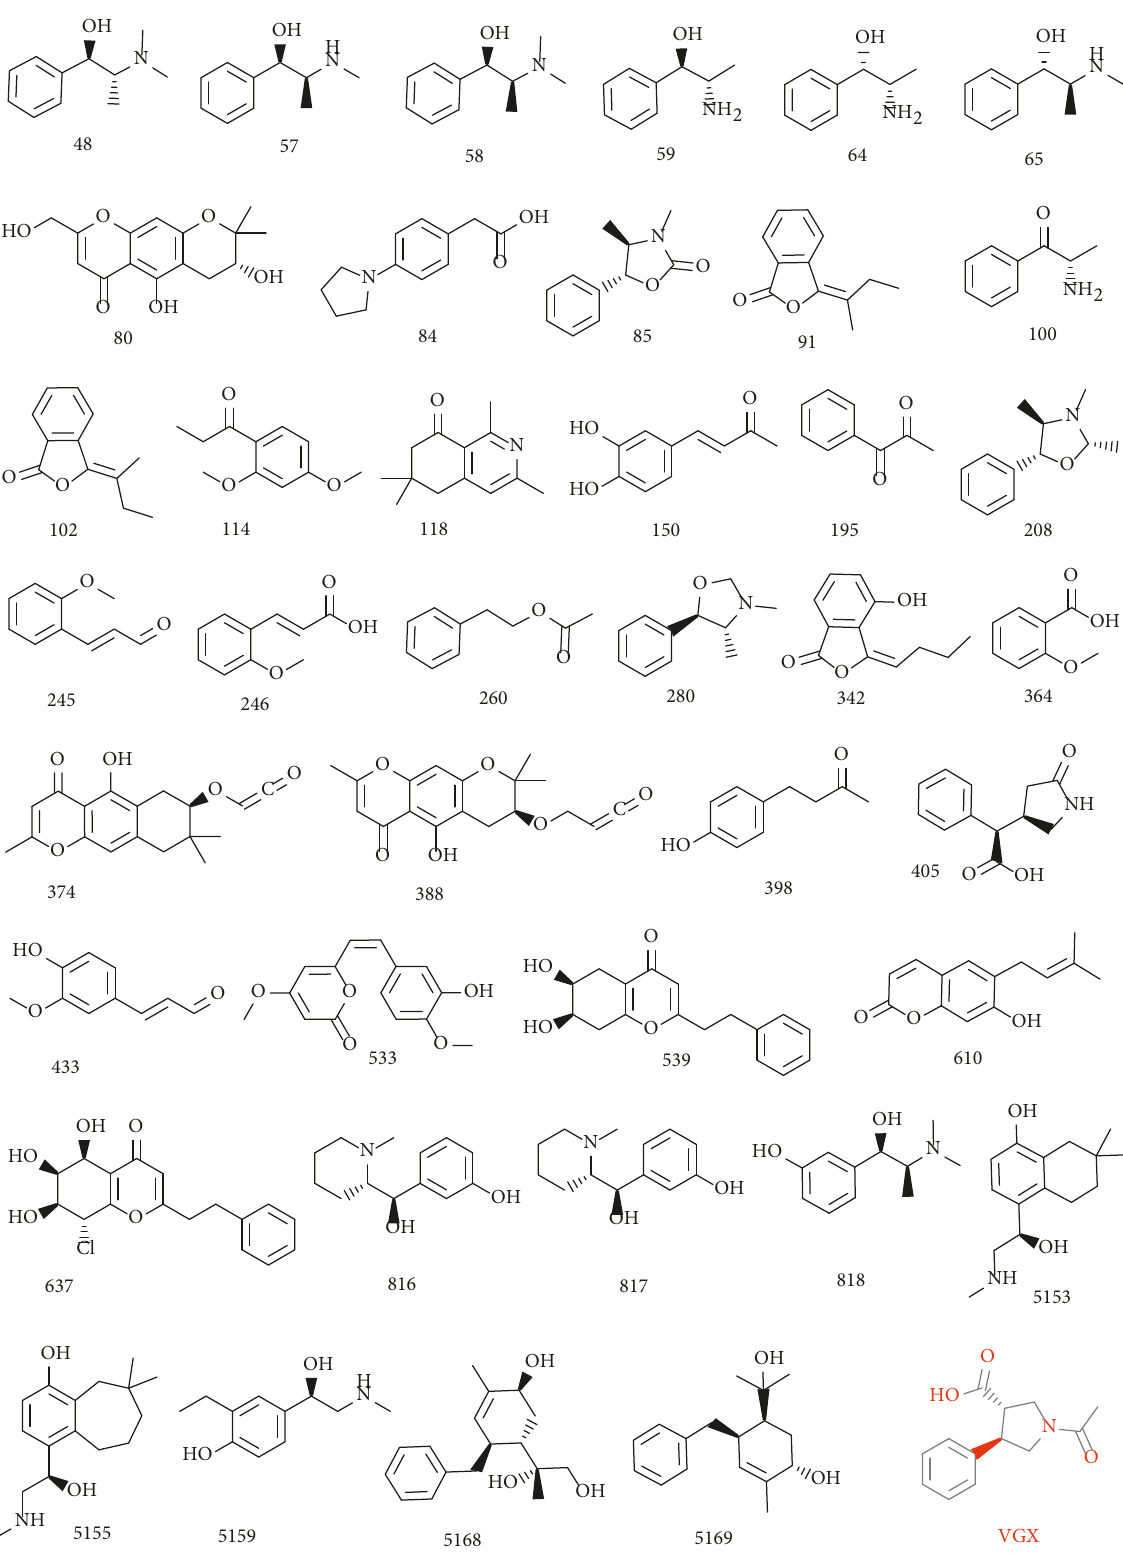
Figure 3: The most similar compounds to VXG